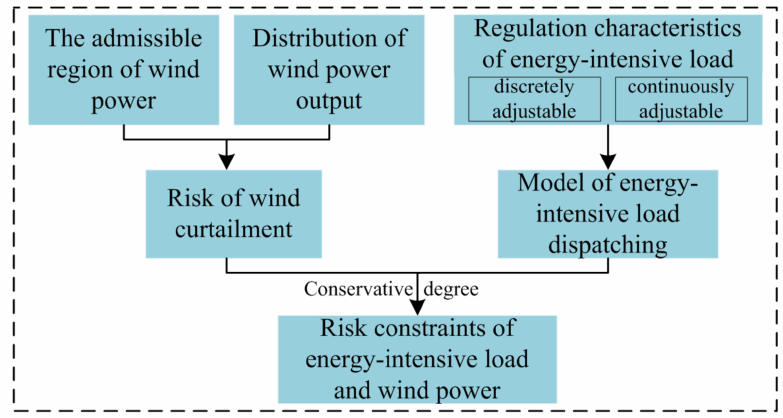
Figure 4. Schematic diagram of risk constraints of energy-intensive load and wind power.